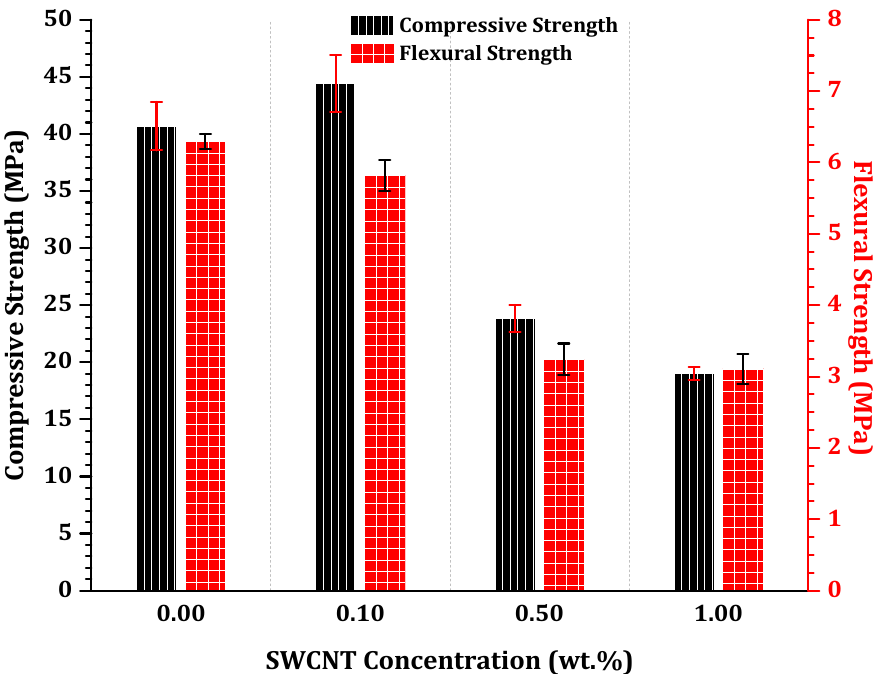
Figure 5. Compressive and flexural strengths of 28-day one-part SWCNT-alkali-activated nano- composites.